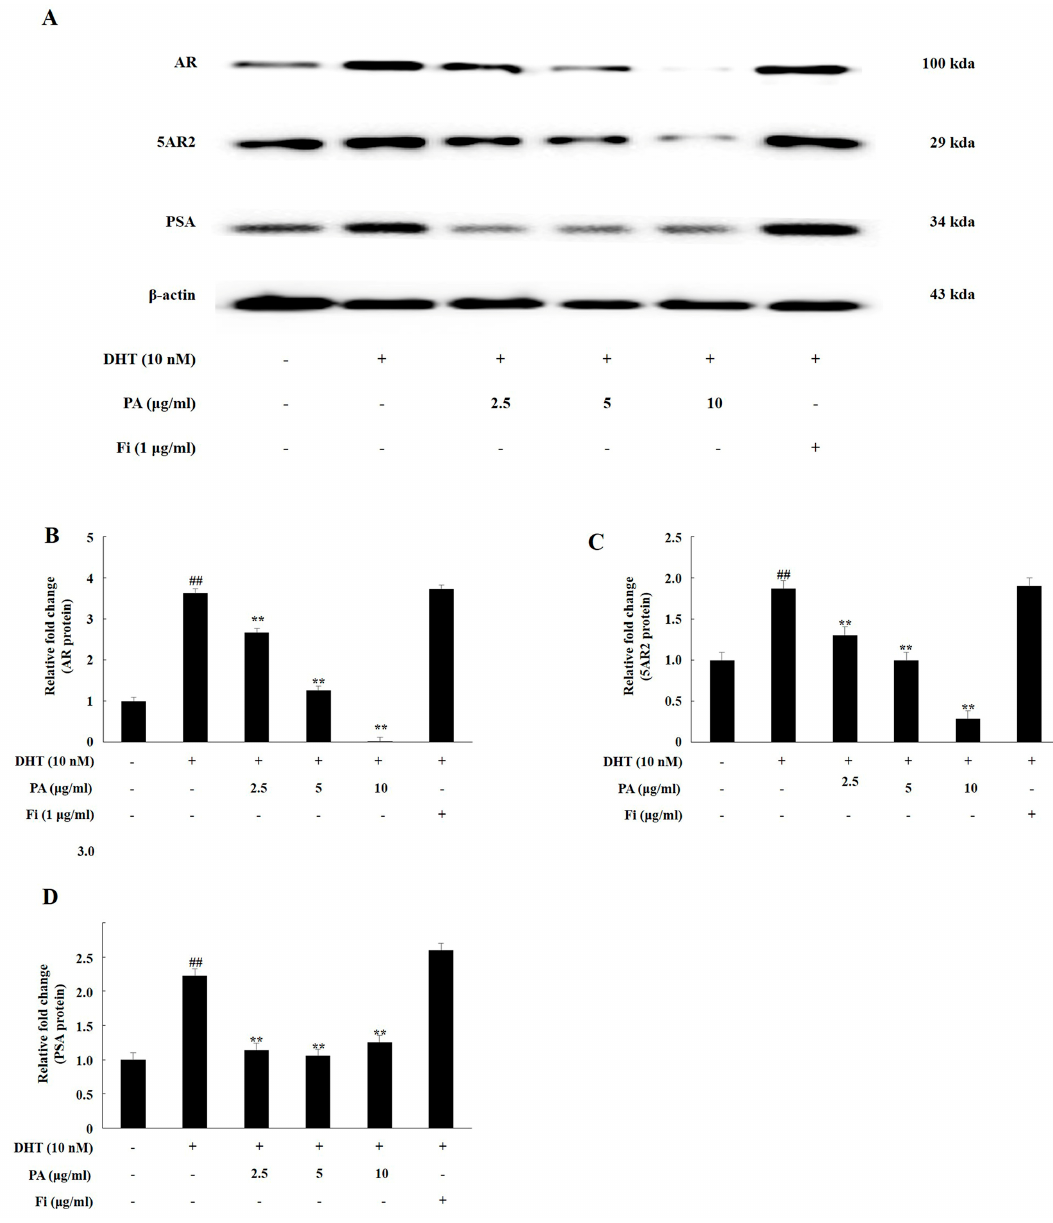
Figure 1. Polymerized anthocyanin (PA) downregulated the expression of androgen receptor (AR), 5- α reductase type 2 (5AR2), and prostate-specific antigen (PSA) in testosterone propionate (TP)-treated LNCaP cells. Western blotting analysis was used to detect the levels of the AR, 5AR2, and PSA proteins. LNCaP cells were treated in Roswell Park Memorial Institute (RPMI) containing TP (100 nmol), PA (2.5, 5, or 10 μ g/mL), or Fi (1 μ g/ml) for 72 h. Western blot was used to measure protein levels of AR, 5AR2, and PSA in LNCaP cells. ( A ). Expression levels of the AR ( B ), 5AR2 ( C ), and PSA ( D ) proteins are shown; the relative protein expression levels were determined by normalization to that of β -actin. The data are expressed as the means ± SEMs. ## p < 0.01, compared with the non-treated cells; ** p < 0.01, compared with the TP-treated cells.